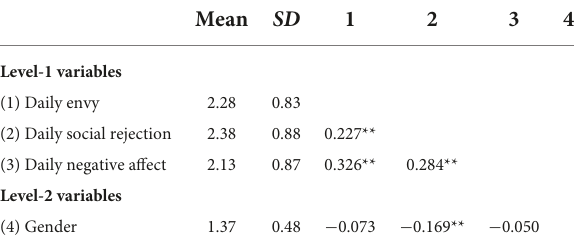
TABLE 1 Means, standard deviations, and correlations of the study variables for the hypothesized